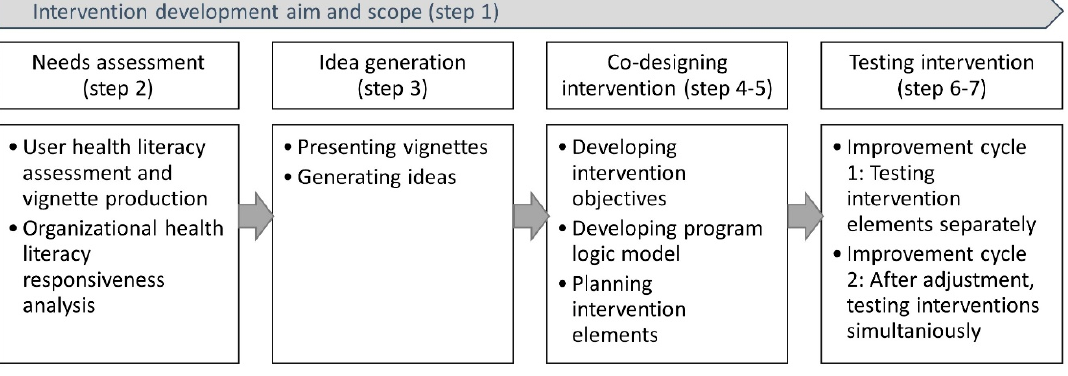
Figure 2. Application of the extended Ophelia approach to develop a health literacy responsiveness intervention in Randers Municipal Rehabilitation Unit